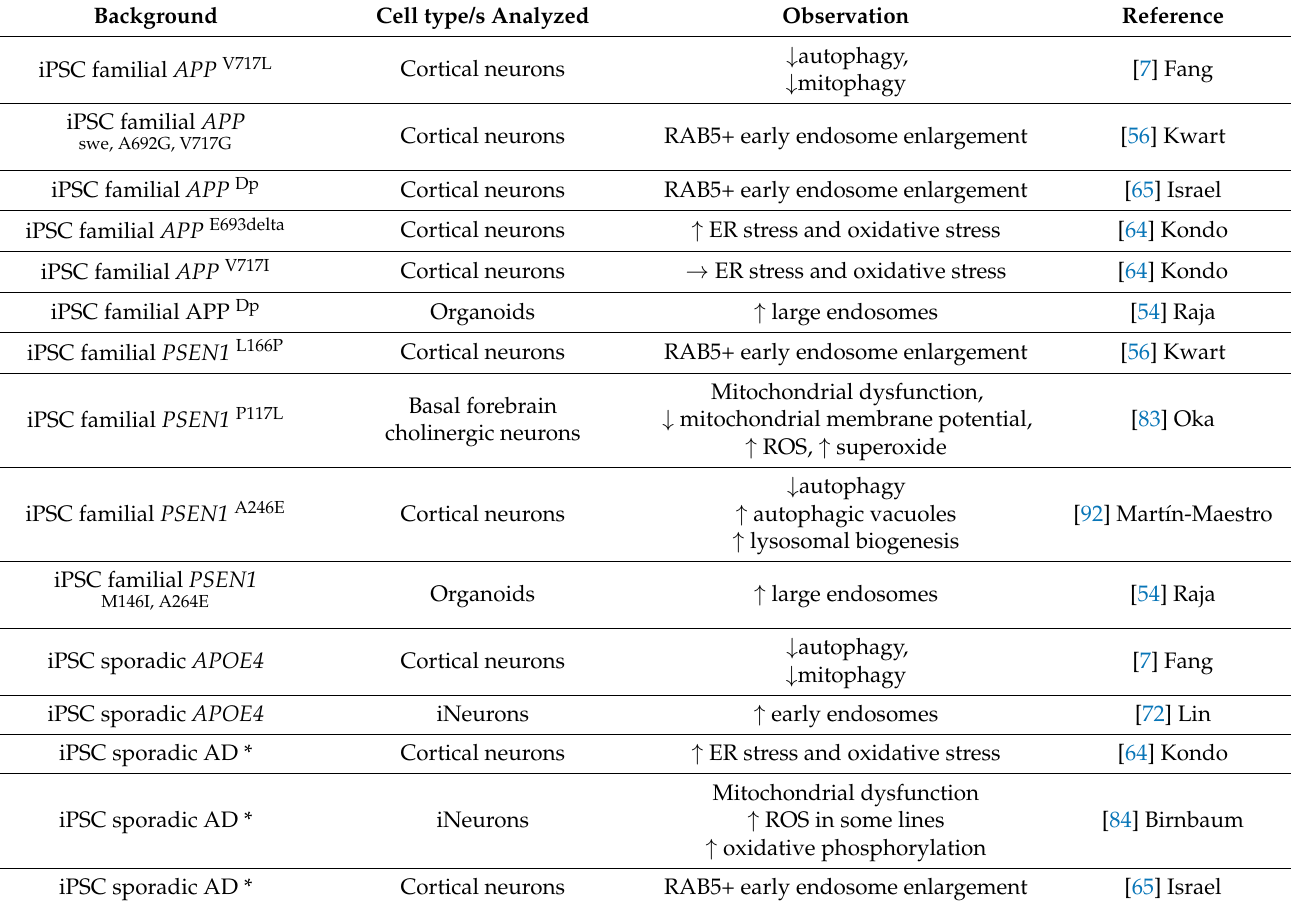
Table 3. Overview of organelle pathology modelled in AD-iPSC neurons and glia harboring either familial mutations, sporadic mutations or from late-onset sporadic AD